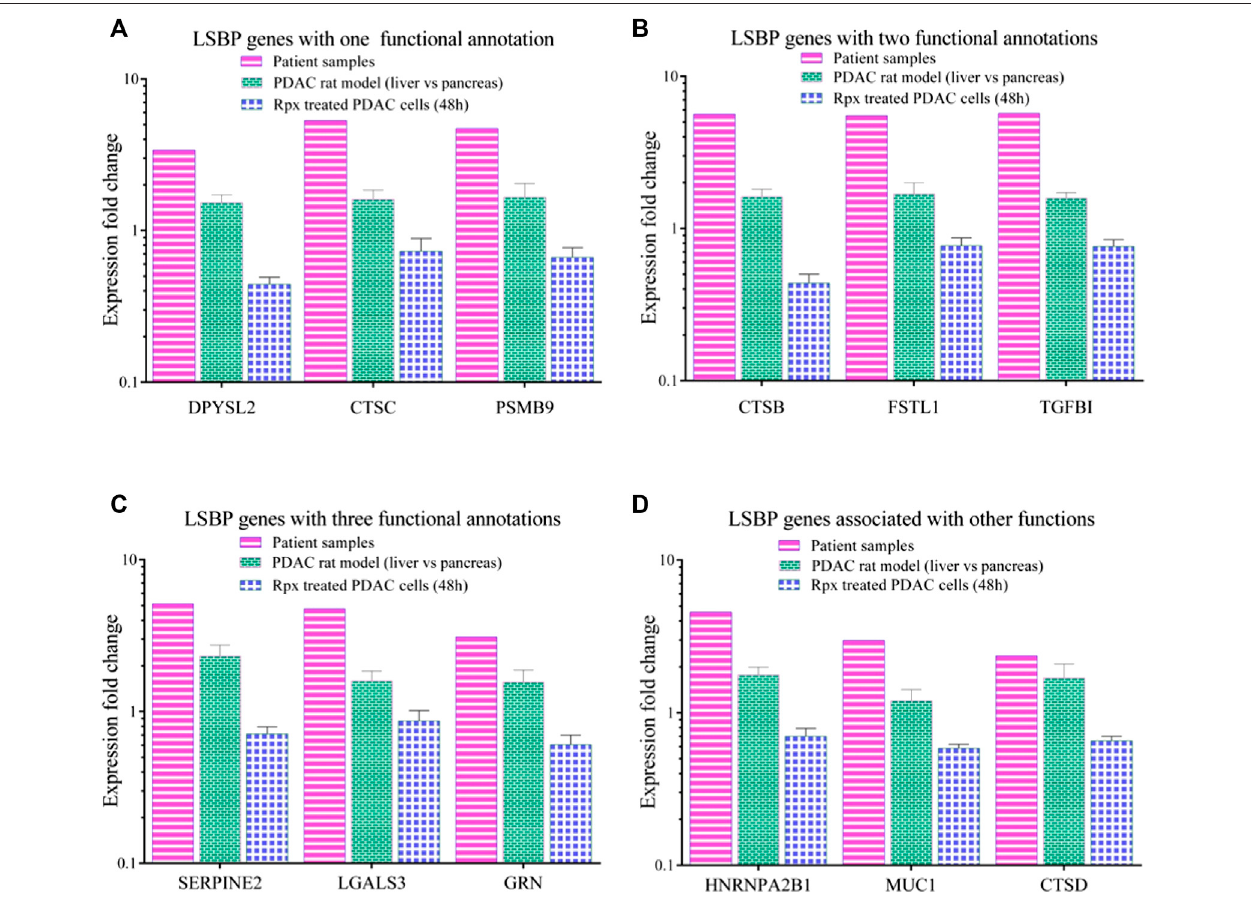
FIGURE 6 | Comparison of modulated LSBP genes selected from three functional annotations. (A – C) Represent bar graphs of LSBPs genes selected from (E) , which were involved in one or more functionalannotations. The colors representthe respective data sets from which they originate, i.e. human samples (pink), ratmodel (green) and Rpx-treated Suit2-007 cells (blue). The genes selected are related to one (A), two (B) or three (C) functional annotations as detailed in (D) . (D) Represents genes related to different functions.